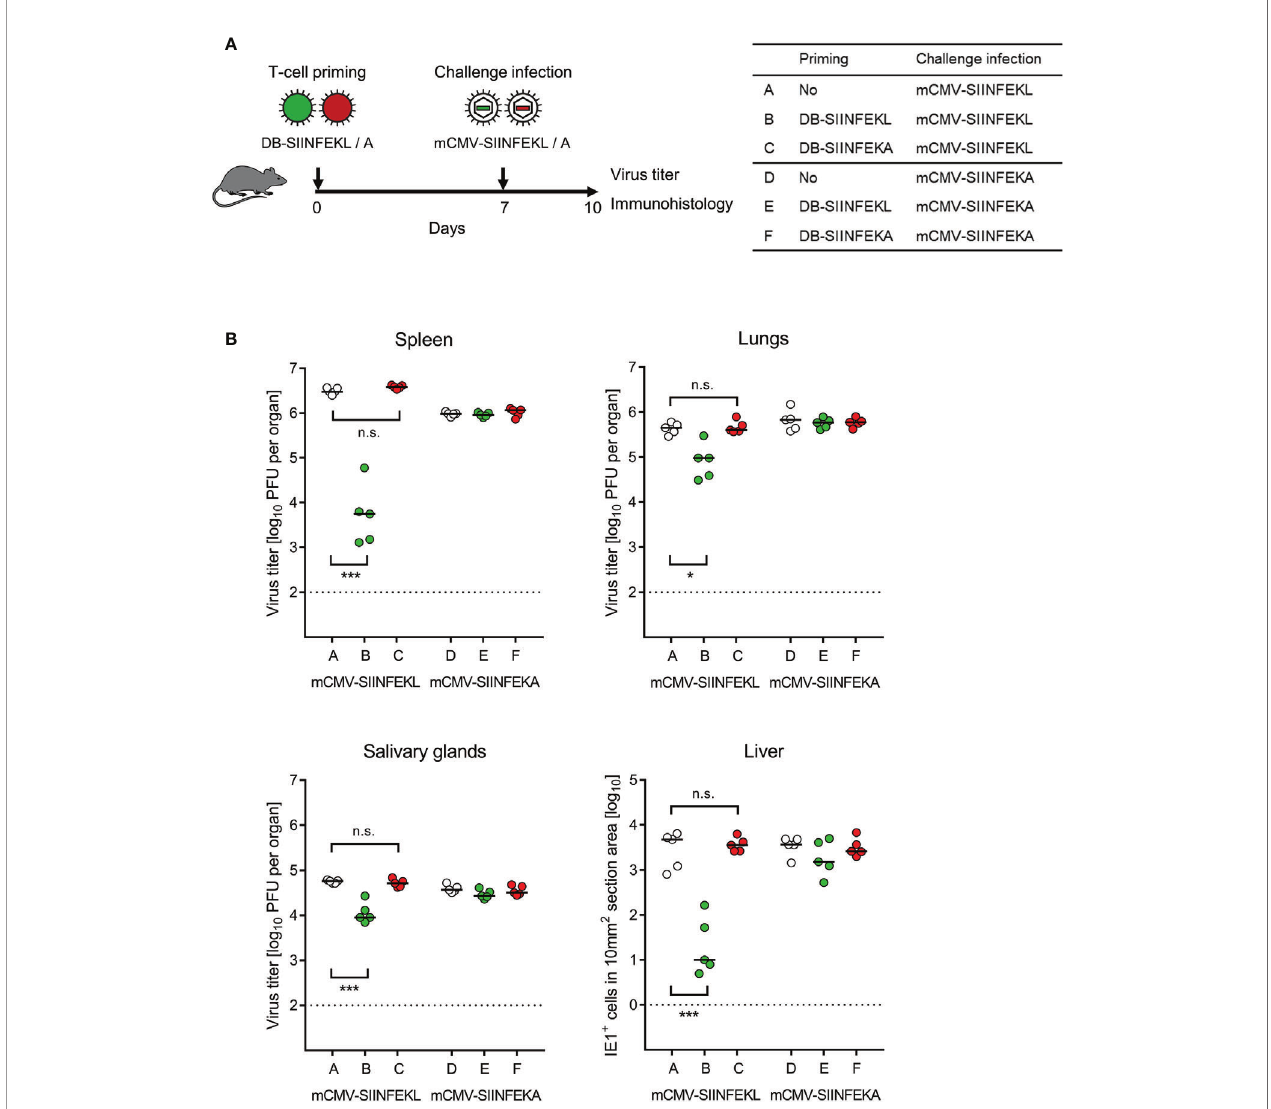
FIGURE 6 | Protection against challenge infection by vaccination with recombinant DBs. (A) Sketch of the protocol and table of experimental groups A – F. Immunocompetent C57BL/6 mice were primed (vaccinated) by intraplantar application of 20- m g doses of DB-SIINFEKL or DB-SIINFEKA. High-dose (10 6 PFU) intravenous challenge infections with mCMV-SIINFEKL or mCMV-SIINFEKA were performed on day 7 after priming (vaccination). Control of organ infection was assessed on day 10. (B) Virus titers in spleen, lungs, and salivary glands, as well as numbers of infected IE1 + liver tissue cells in representative 10-mm 2 section areas. Symbols (open circles: no vaccination; green closed circles: vaccination with DB-SIINFEKL; red closed circles: vaccination with DB-SIINFEKA) represent data from individually tested mice, with the median values marked. Signi fi cance levels (*) P < 0.05, (***) P < 0.001. (n.s.), not signi fi cant ( P > 0.05). (Dotted lines), detection limits of the